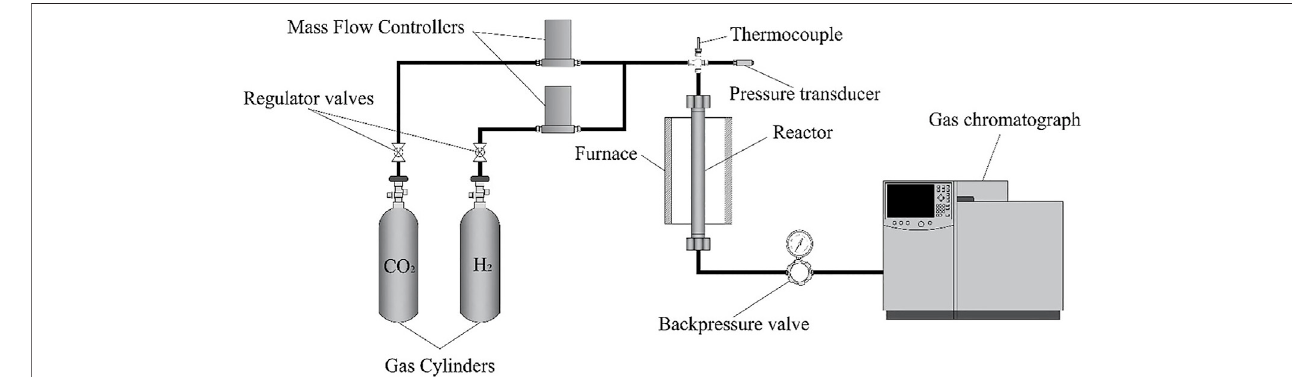
FIGURE 1 | Experimental setup.